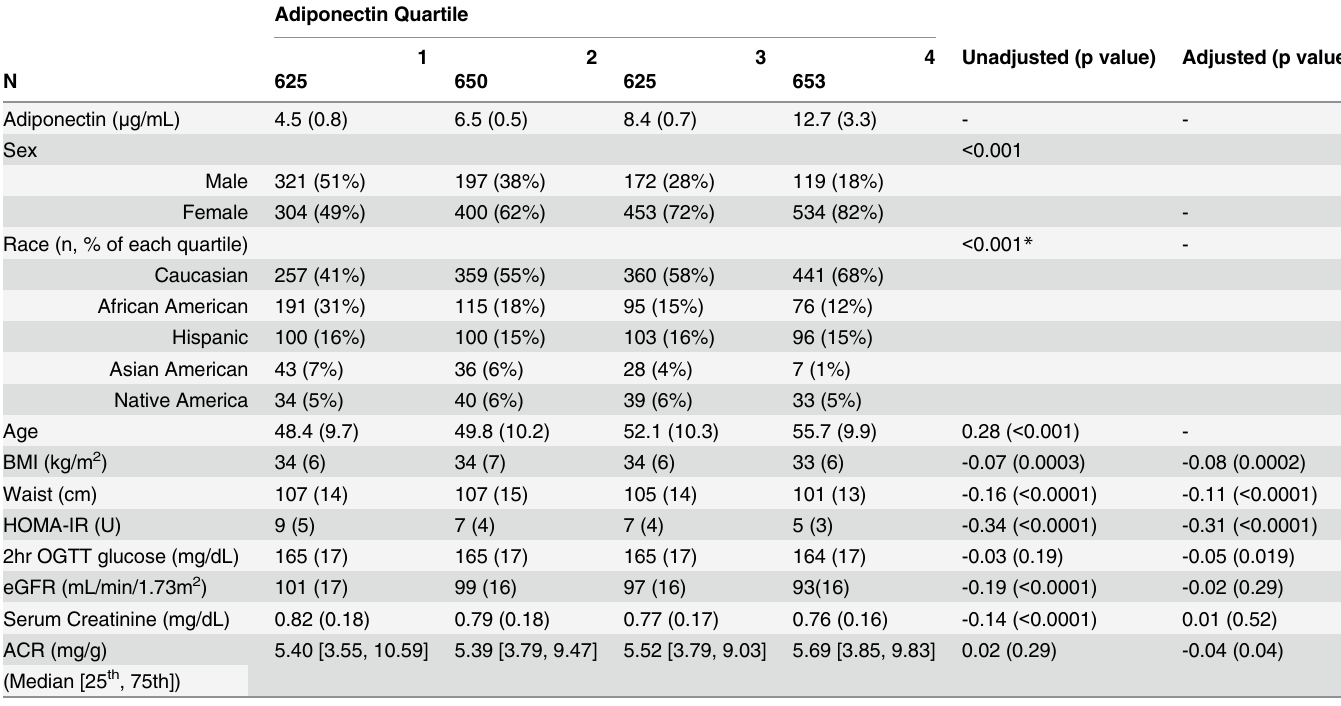
Table 2. Relationships of albuminuria, renal function, and metabolic variables with adiponectin concentrations at baseline. All variables are pre- sented as mean (SD) except as noted for ACR, which is highly skewed. Spearman ’ s correlations are presented for continuous variables versus baseline adi- ponectin levels. For categorical variables such as race and sex, the distributions of adiponectin within each category were compared using the Kruskal- Wallace test (denoted by * ). Results are presented for unadjusted correlations, and following adjustment for race/ethnicity, sex and age. The numbers of indi- viduals in each quartile are unequal due to ties, which are included in the higher quartile.